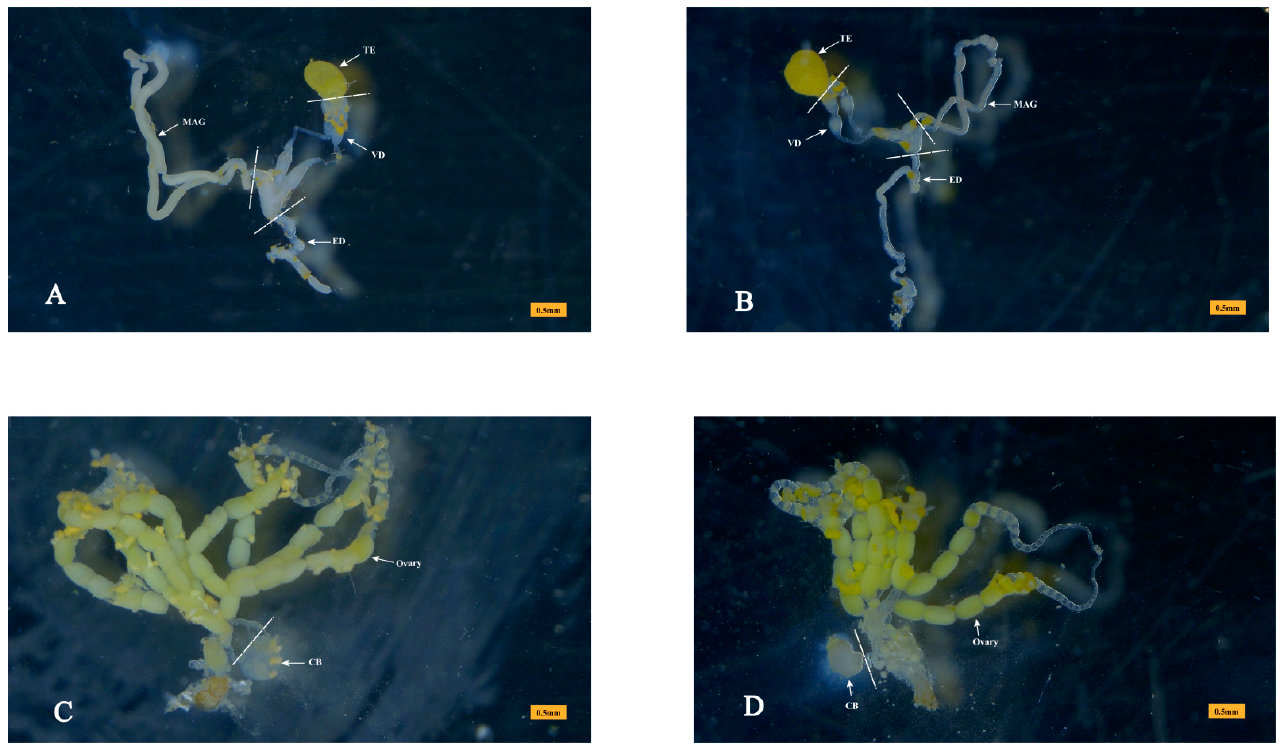
Figure 1. Tissues dissected for sample preparation. ( A ) The reproductive system of virgin male Plutella xylostella . Approximately 200 male accessory glands (MAGs) were dissected as a virgin-MAG protein sample, with 3 biological replicates. For qRT-PCR, testis (TE), MAG, and vas deferen (VD) were dissected from 50 virgin males, and 3 biological replicates were performed for each tissue. Ejaculatory duct (ED) is also shown. ( B ) The reproductive system of mated male P. xylostella . A mated-MAG protein sample was dissected from approximately 200 mated males, with 3 biological replicates. ( C ) The reproductive system of a virgin female P. xylostella . The copulatory bursa (CB) was dissected from 50 virgin females for qRT-PCR, and 3 biological replicates were performed. ( D ) The reproductive system of mated female P. xylostella . Approximately 200 CB were dissected as a mated-CB protein sample with 3 biological replicates. Each tissue sample was dissected from the dotted line.